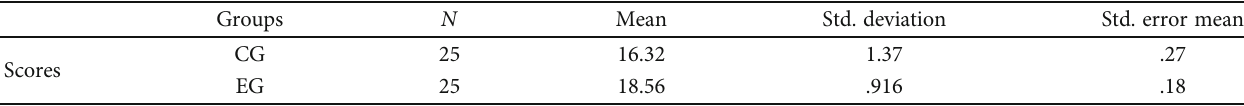
Table 3: Descriptive statistics of the grammar posttests.